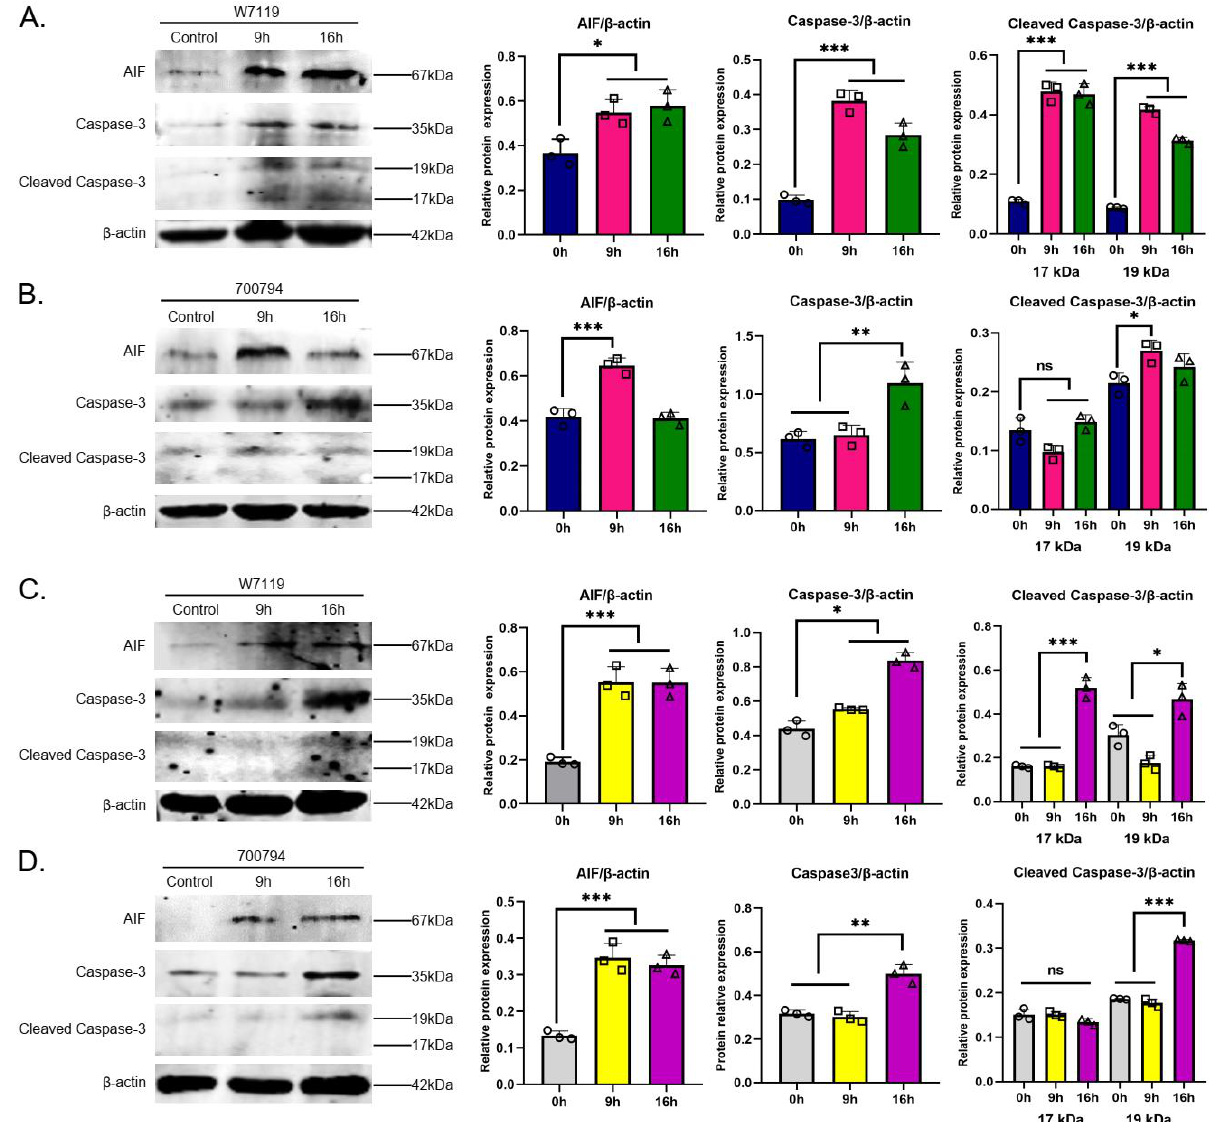
Figure 7. S. suis induces caspase- and p53-dependent apoptosis in PAM cells. PAM-Tang cells were infected with ( A ) S. suis avir-W7119 or ( B ) S. suis vir-700794, and primary PAMs were infected with